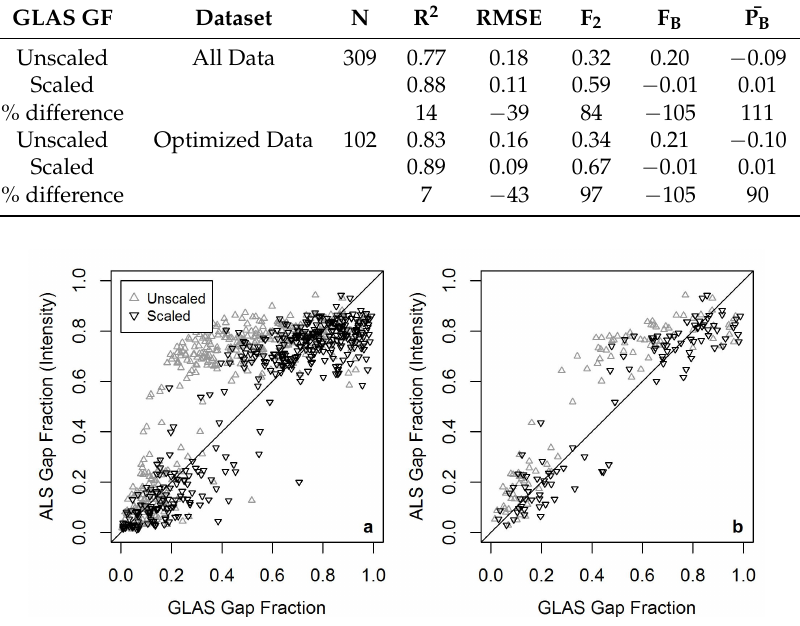
Figure 5. Comparison of ALS and GLAS unscaled (grey) and scaled (black) estimates of GF where scaling factors were predicted via an RF model trained with the best suited predictor attributes using ( a ) all available training data and ( b ) an optimized